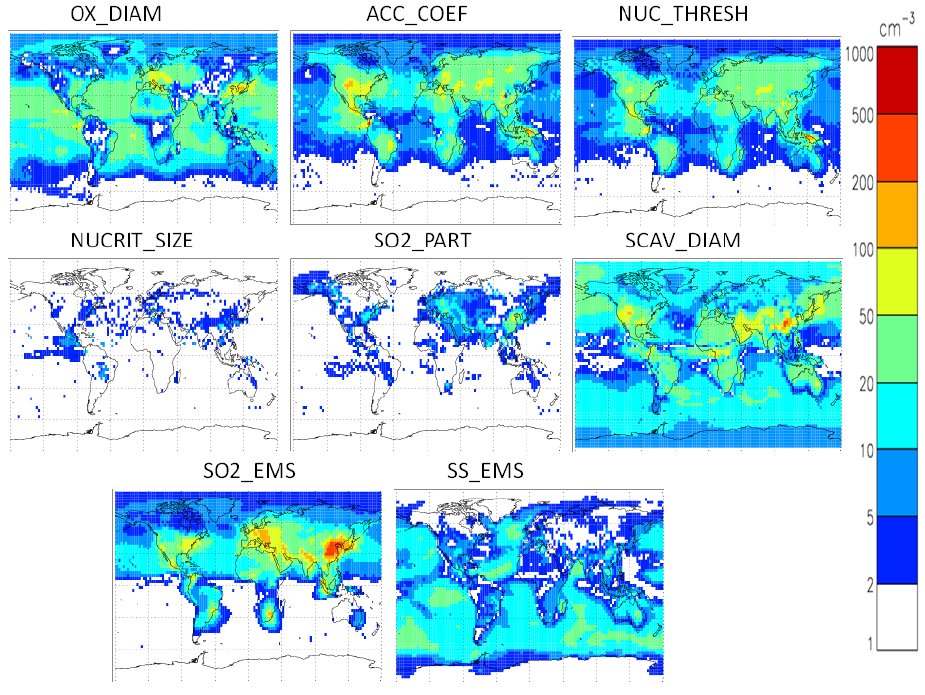
Fig. 5. The absolute July 2000 CCN standard deviation due to uncertainty in each of the 8 parameters in Table 1. The absolute standard deviation compared to the most sensitive parameters can help modellers choose which of the parameters is most important in the attempt to reduce uncertainty in global CCN